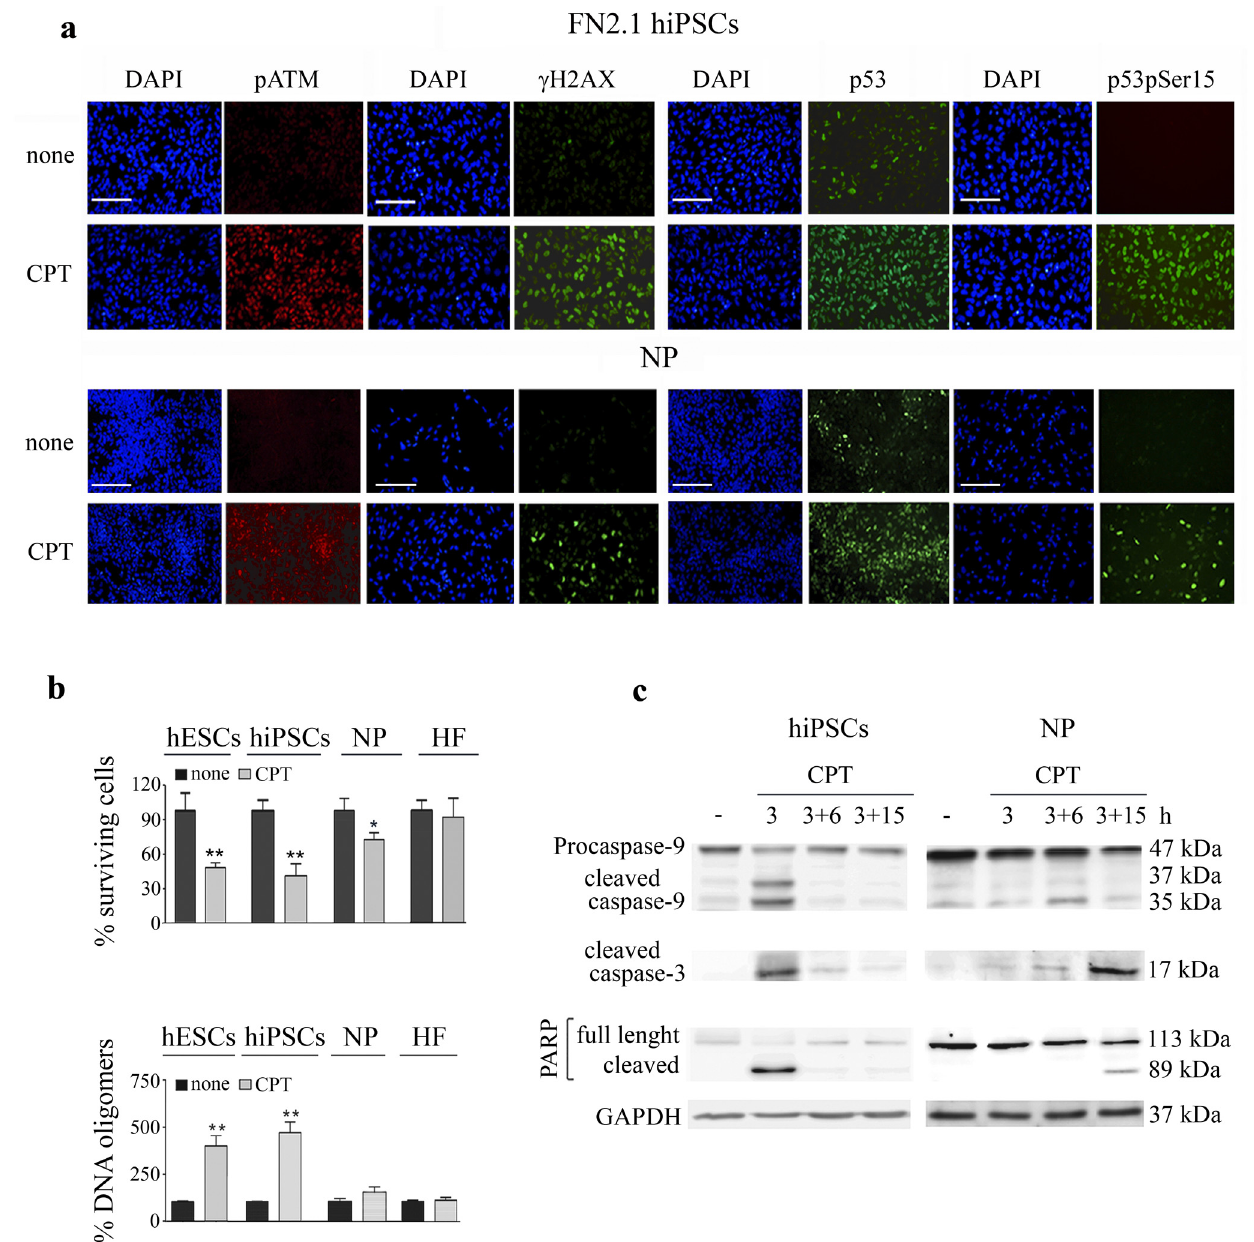
Fig 2. CPT activates DNA damage response and triggers apoptosis in hiPSCs and hESCs-derived NP. (a) Immunofluorescence photomicrographs of genotoxic-treated (1 μ M during 3 h) hiPSCs and NP performed immediately after CPT treatment (1 μ M during 3 h). The figure shows representative images of cells stained with primary antibodies against ATM phospho-serine1981 (pATM), histone γ H2AX, p53, p53 phospho serine 15 (p53pSer15). Nuclei were counterstained with DAPI. The scale bars represent 100 μ m. (b) Cell viability was measured in hESCs, hiPSCs, NP and HF treated or not with 1 μ M CPT during 3h by the XTT/PMS assay 6 h after drug removal (top panel). Results are presented as the percentage of the viability of untreated cells. Each bar represents the mean ± SEM of three independent experiments performed in quintuplicate. A paired Student ’ s t test was used to compare CPT treated samples to untreated controls. After a withdrawal period of 3 h CPT-treated cells were harvested, and DNA oligomers were quantified by immunoassay (bottom panel). Results are presented as the percentage of DNA oligomers of untreated cells. Each bar represents the mean ± SEM of three independent experiments performed in triplicate. * P < 0.05, ** P < 0.001. (c) Time course of caspase-9, caspase-3 and PARP cleavages in hiPSCs and NP upon CPT treatment were analyzed by Western blotting with anti-caspase-9, anti-cleaved-caspase-3 and anti-PARP specific antibodies, immediately after (3 h), 6 h or 15 h post drug removal (3+6, 3+15, respectively). GAPDH was used as loading